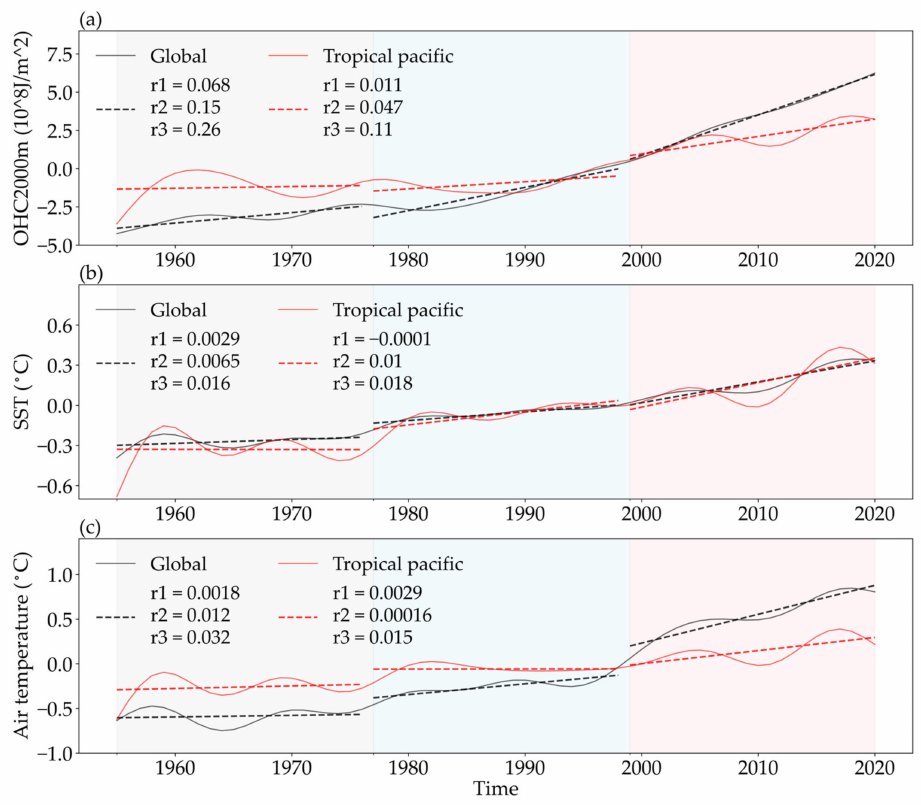
Figure 1. The annual mean series of ( a ) 0–2000 m ocean heat content anomalies, ( b ) sea surface temperature (SST) anomalies, and ( c ) air temperature anomalies at sigma level 0.995. The time series are low-pass filtered for 10 years to retain the decadal variation signal. The black solid line is the global average abnormal values and the red is the area-average abnormal values of the tropical Pacific (30 ◦ N–30 ◦ S, 120 ◦ E–80 ◦ W). The abnormal values are calculated using 1981–2010 as the mean climate state. The dashed lines of the three periods are the linear trends of 1955–1976 (p1; gray background), 1977–1998 (p2; blue background), and 1999–2020 (p3; pink background), respectively. The r1, r2, and r3 are the corresponding linear regression